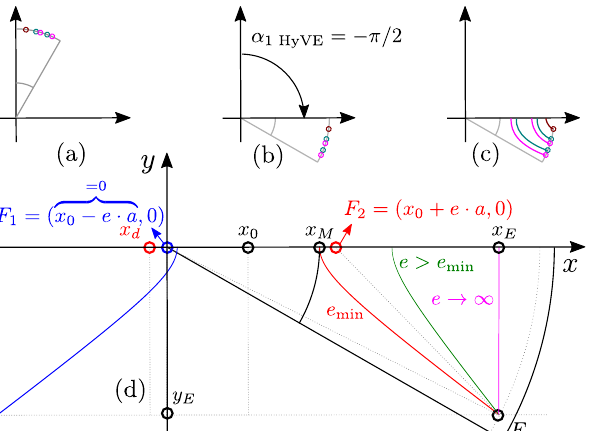
Figure 8. Hyperbolic barrier construction. Subfigures ( a )–( d ) are explained in the Sections